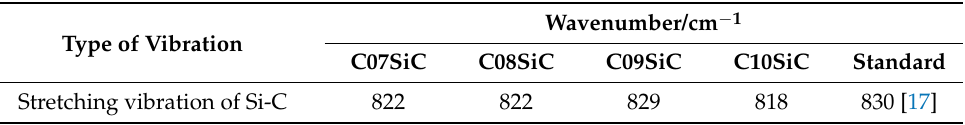
Figure 8. IR spectrum of the calcined product in an air atmosphere at 700 °C after washing with a mixture of HF and CH 3 COOH solutions. Table 6. IR absorption of calcined products at a temperature of 700 ◦ C in air atmosphere after washing with a mixture of HF and CH 3 COOH